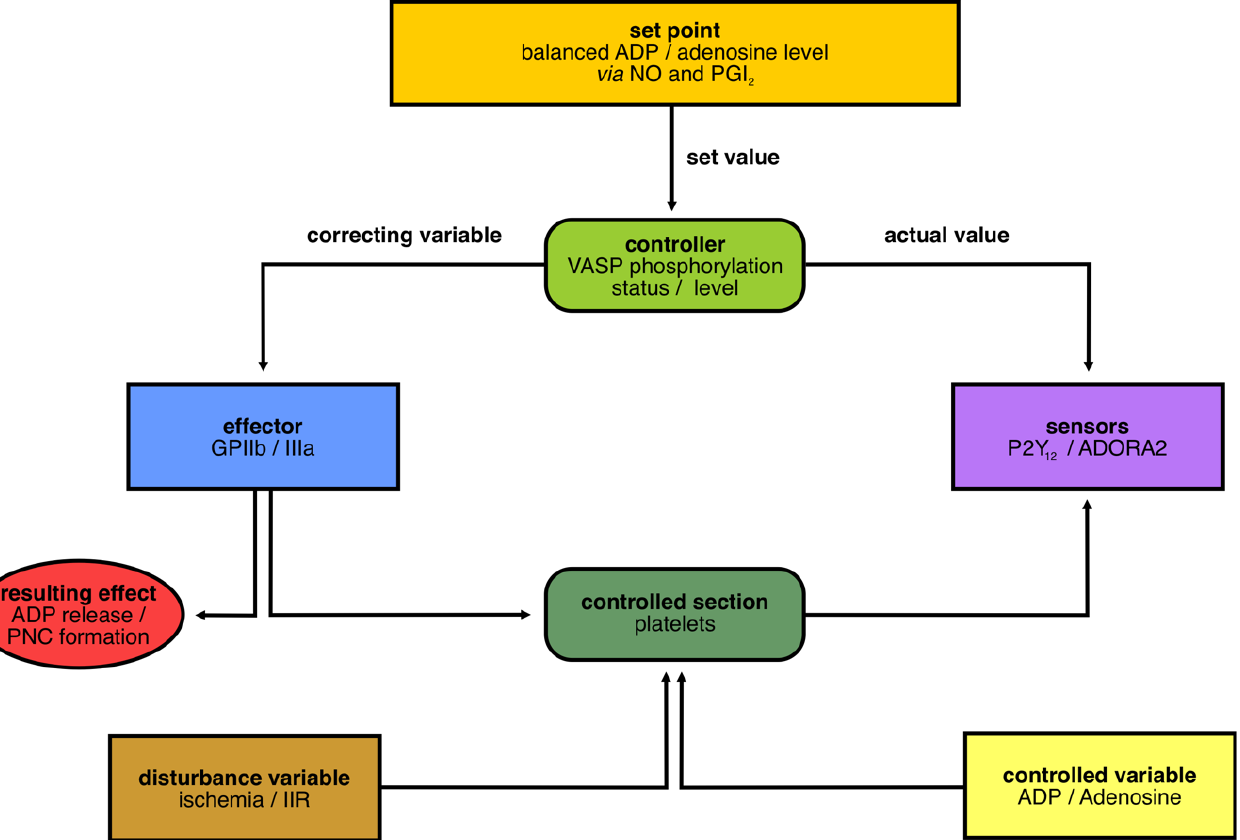
Figure 2. Cybernetic cycle/control circuit in ischemic inflammatory response (IIR) focused on platelets. To describe the role of platelets and their nucleotide metabolism for PNC formation, we first defined a cybernetic system with a balanced ADP/adenosine level as the set point, with the controller VASP, the effector GPIIb/IIIa, with the platelets as controlled section and P2Y 12 and ADORA2 as main sensors. The set point is kept in balance via NO and PGI 2 . The phosphorylation status of the controller VASP regulates the (de)activation status of GPIIb/IIIa. This results in ADP release and PNC formation. Furthermore, disturbance variables, such as ischemia or ischemic inflammatory responses (IIR), act on the controlled section platelets and are counterregulated by the controlled variables ADP and Adenosine.